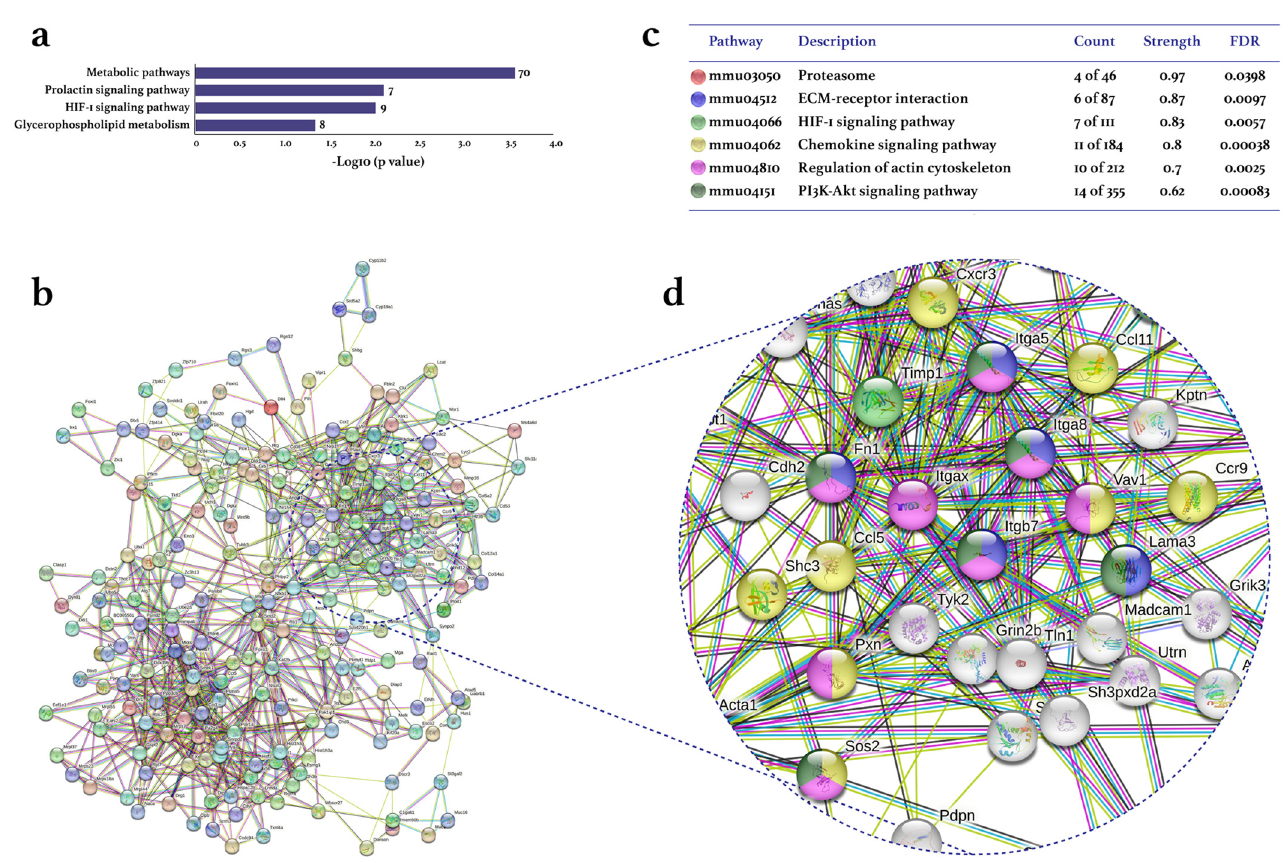
Figure 3. Effect of physical exercise on transcriptomic up-expression in tarsal joints of mice with collagen-induced arthritis. The lists of the up-expressed genes in the CIA-Ex mice with respect to control (Z-score ≥ 1.5 SD) were analyzed on DAVID bioinformatics resource, STRING database, and Cytoscape software (n = 8 mice per group). ( a ) The associated KEGG pathways ( p ≤ 0.05) in DAVID are shown in the bars that indicate the -Log10 ( p -value) and the number of genes on the right side of each bar. ( b ) The primary clusters of sub-networks found with the Molecular Complex Detection (MCODE) complement (cutoff = 0.4) to obtain the protein–protein interaction (PPI) network. ( c ) KEGG signaling pathways relevant in arthritis. ( d ) Amplification of the nodes with the most significant interaction in the selected pathways. FDR: false discovery rate.